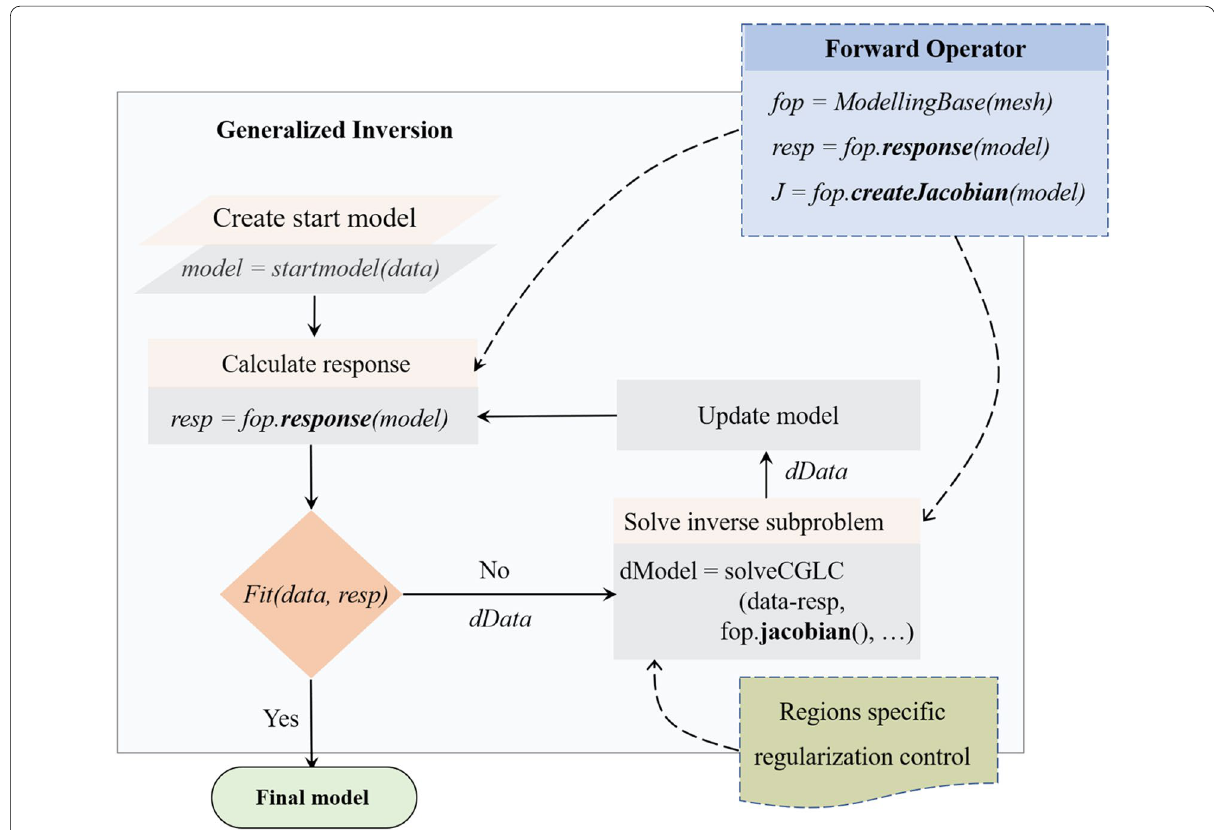
Fig. 1 pyGIMLi generalized inversion scheme (Rücker et al.